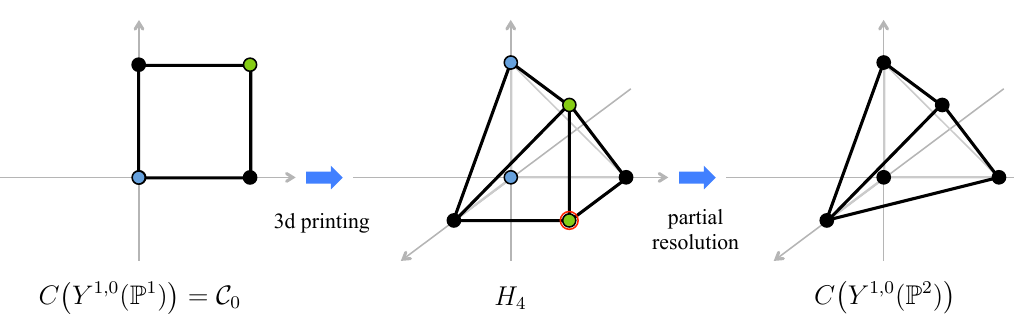
Figure 5. Generation of the toric diagram for C ( Y 1 ; 0 ( P 2 )). Starting from the conifold, two points of the toric diagram are lifted by 3d printing. Finally, another point is removed by partial